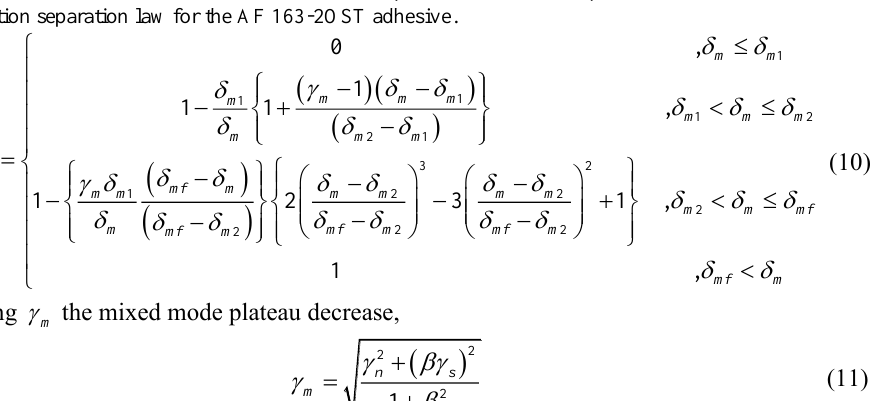
Figure 2. (a) Illustration of the CZM traction-separation law. (b) Temperature tabulated calibrated traction separation law for the AF 163-2OST